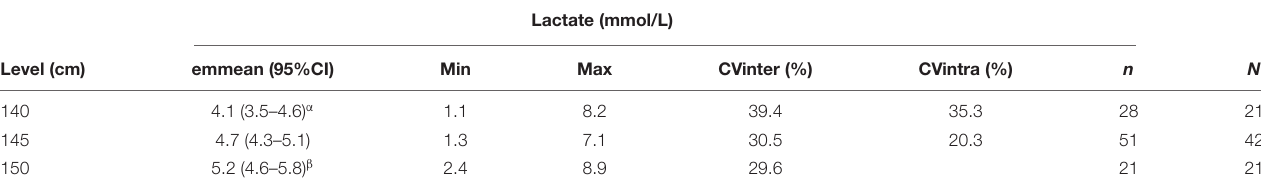
TABLE 1 | Estimated marginal means, minima, maxima, and inter- and intra-individual coefficients of variation for blood lactate concentration in response to show-jumping competitions at different